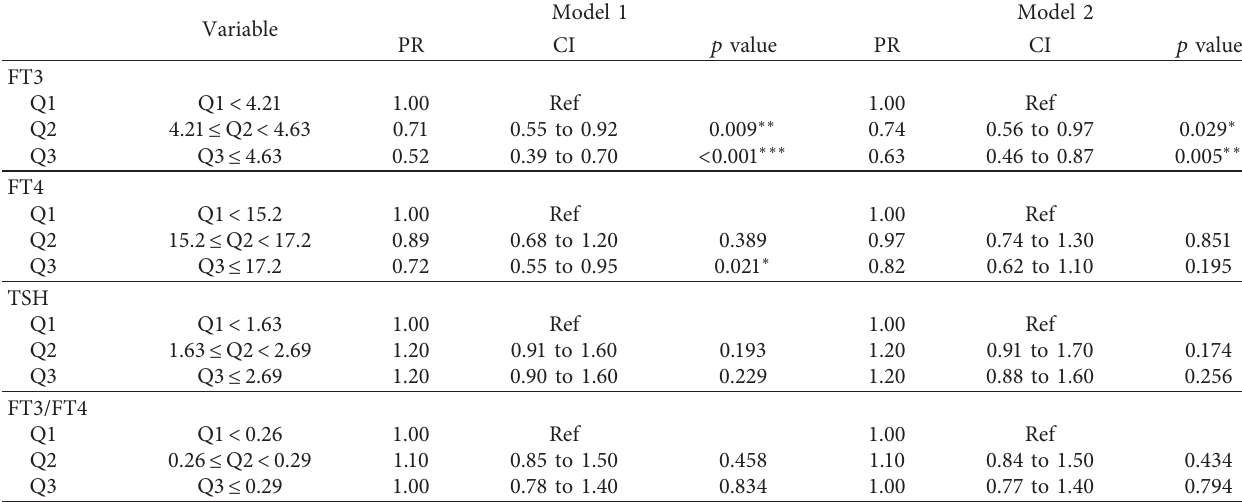
Table 3: Prevalence ratio of atherosclerosis based on Cox regression on each tertile of thyroid hormone